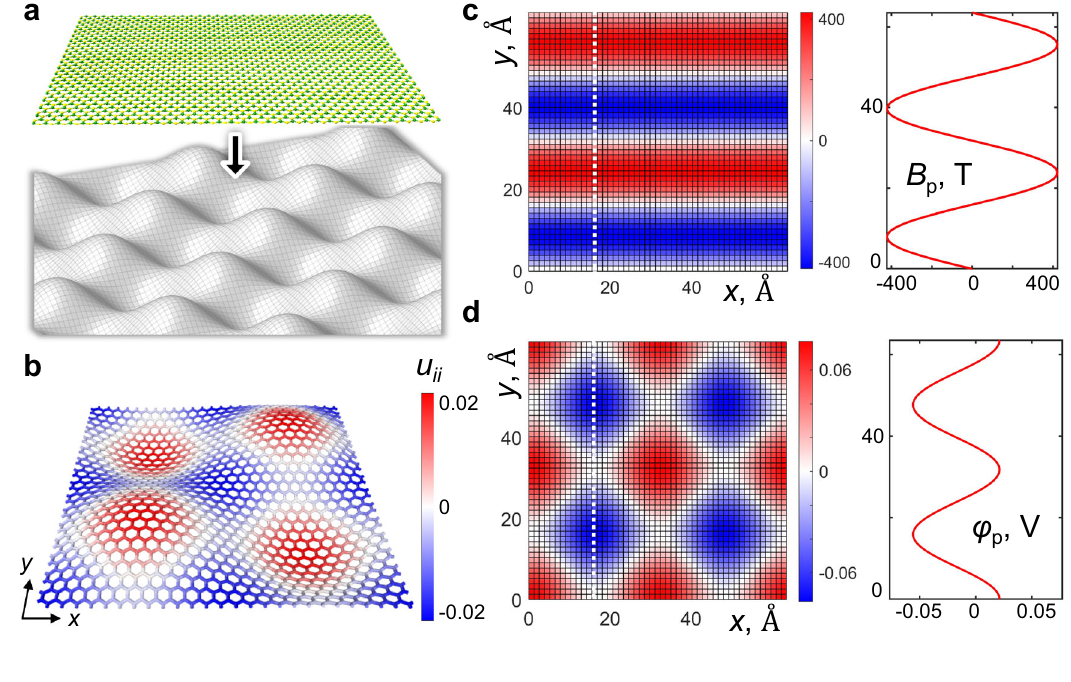
Fig. 1 Design scheme to create fl at bands using mechanical deformation induced pseudo-electric and magnetic fi elds. a A 2D material stamped on a topography with bi-periodic sinusoidal height-modulation, causing in-plain strain. b Relaxed h-BN geometry and strain fi eld ε ≡ u ii at undulation aspect ratio A = 0.079. The left panels in c , d map the pseudo-magnetic ( B φ fi elds, respectively; the right panels show the values of P ) and pseudo-electric potential ( p ) the respective fi elds along x = const, marked by a white dashed line on the